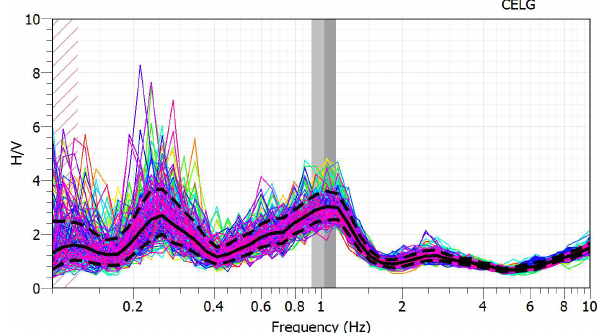
Figure 4. H/V Spectral ratios of the broad band station CELG. The black continuous line is the mean of the H/V spectral ratio obtained at each time-window (thin colored lines). The dashed black lines are the standard deviations. The grey band identifies the f 0